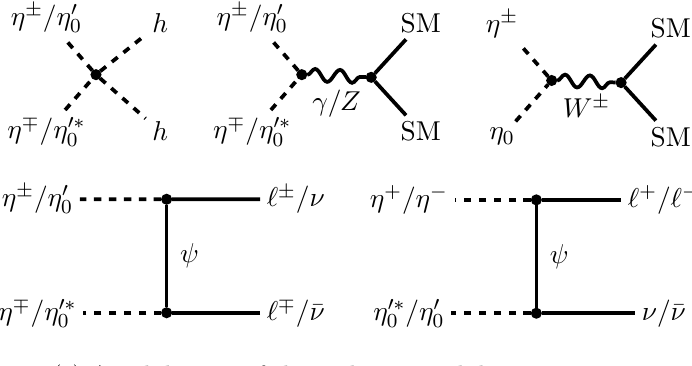
. We also show diagrams of the annihila- 0 (bottom panel). More diagrams exist involving 0